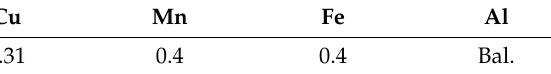
Table 1. Chemical composition of Aluminum Alloy 6082 (wt%) used in the study. Si Mg Cu Mn Fe Al 0.89 1.18 0.31 0.4 0.4